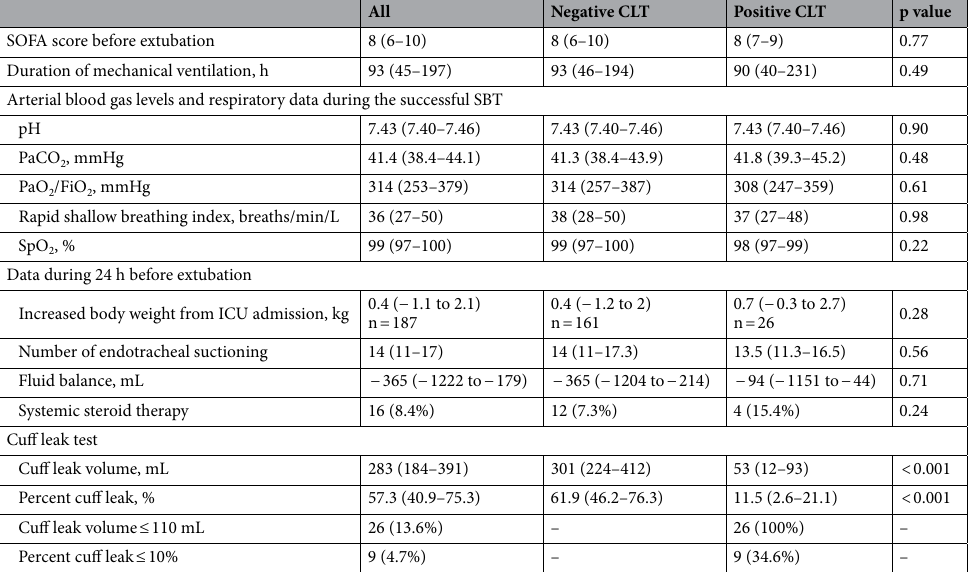
Patients without PES (n = 172) Patients with PES (n = 19) p